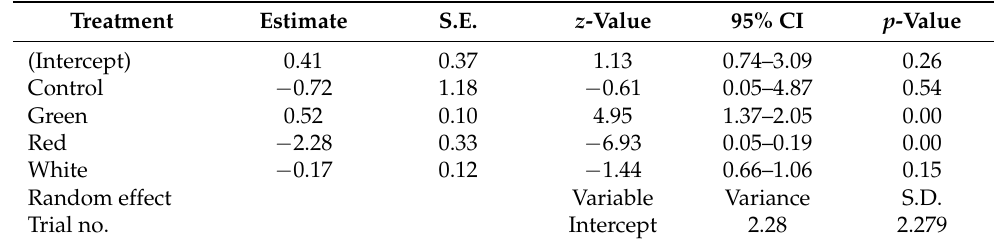
Figure 5. Catch Per Unit Effort (CPUE) comparison between the control and treatment pots for BSR. Table 3. Parameter estimates, fit statistics, and variation from the random effects of a GLMM model for BSR based on trial number as a random factor ( n = 21).